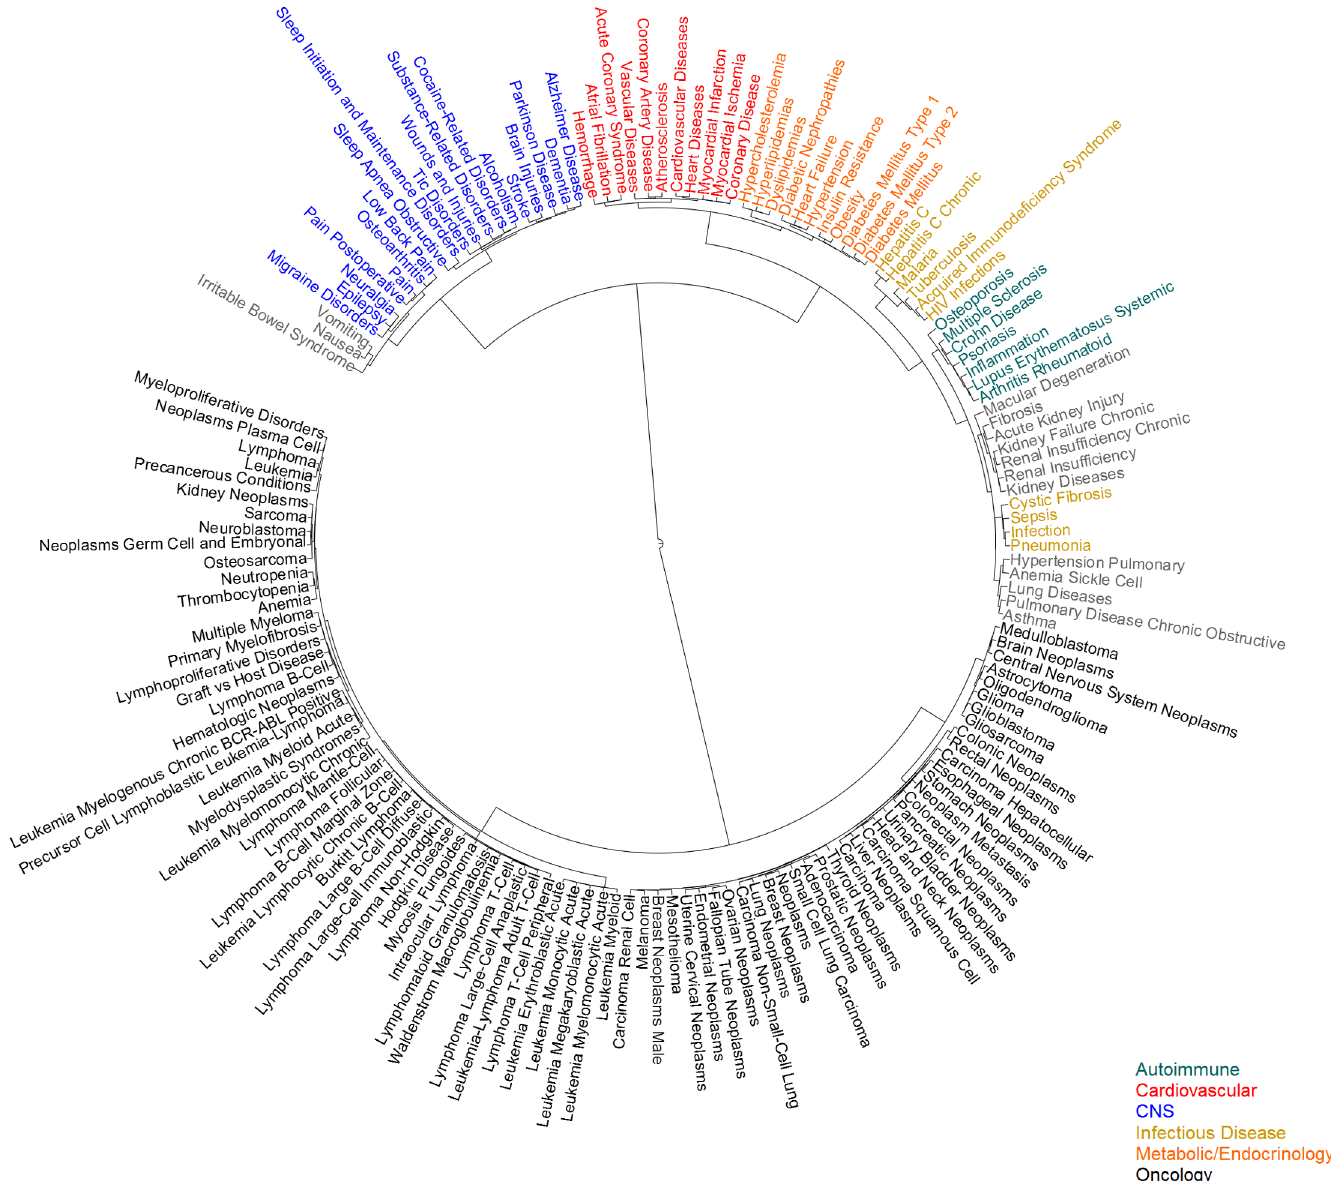
Fig 3. Drug-centric hierarchical clustering of diseases. One hundred fifty-six diseases from the Clinical dataset were clustered using a distance metric based on the drugs adopted by each disease. Several clusters were colored based on the class of diseases that prevailed in the cluster: autoimmune/ inflammation (blue-green), cardiovascular (red), CNS (blue), infectious disease (gold), metabolic/endocrinology (orange), oncology